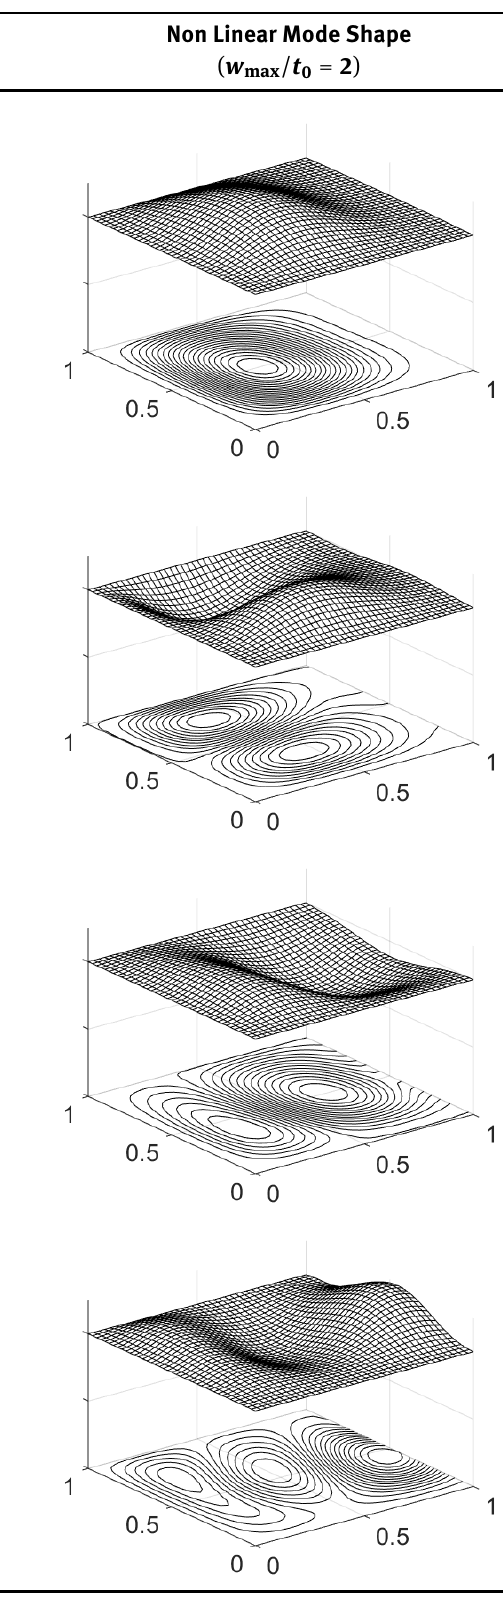
Figure 9: Linear and non-linear mode shape plots for CCSF plate at K f = 10000 and α , β =